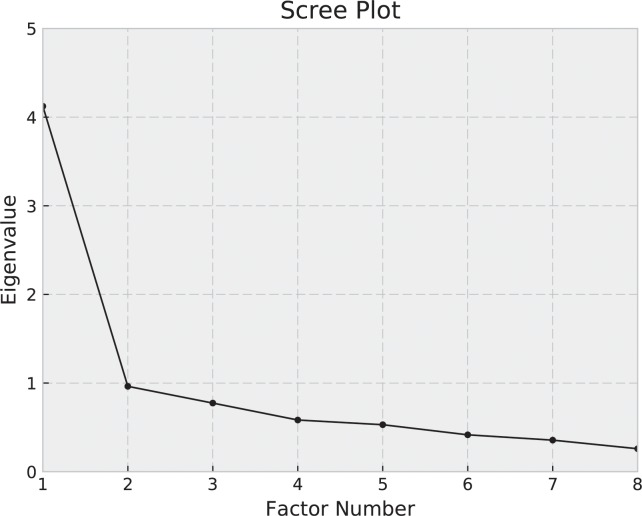
Scree plot of Lysholm score.